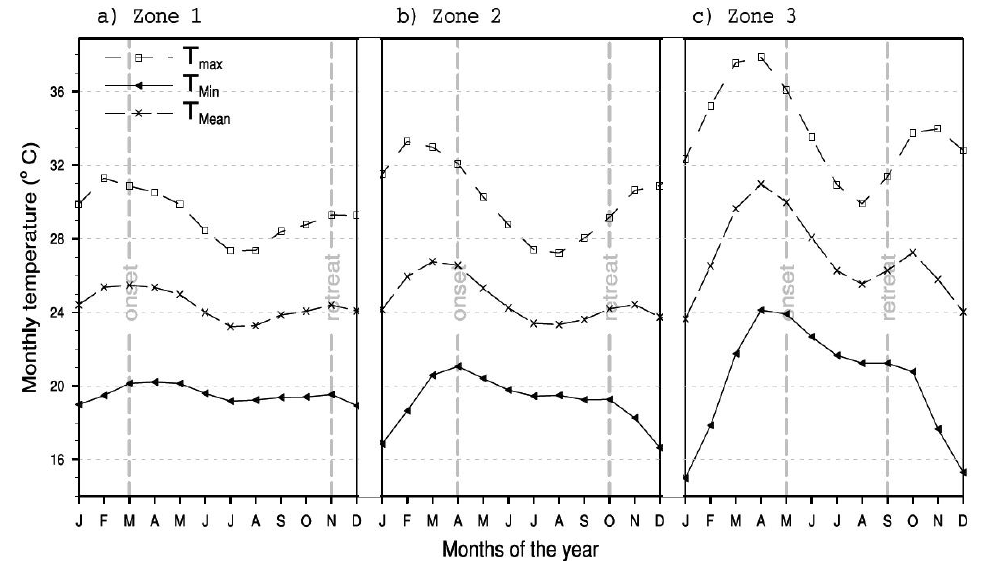
Figure 5. Annual cycles of average, minimum and maximum temperatures (T mean , T min and T max respectively, expressed in ◦ C) for the period 1962–1993: ( a ) for the Equatorial forest zone named Zone 1 (south of study area); ( b ) for the transition zone between the Equatorial forest zone and the Sahel zone named Zone 2; and ( c ) for the Sahelian zone named Zone 3 (north of study area). For each zone, there are two gray vertical dashed lines representing the mean onset and retreat month of the rainy season [30]. These months are absolutes and correspond to those containing onset and retreat dates in terms of pentads and their variabilities (not more than six pentads for the highest range). The labels on the x-axis (J, F, ..., D) indicate the months of the year (January, February, ..., December)